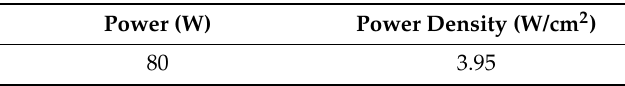
Table 1. The power densities applied on ZnO target.